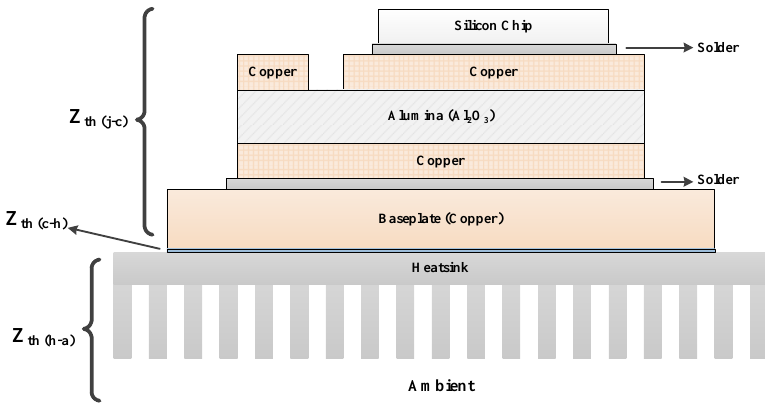
Figure 7. Cross−sectional representation of IGBT power module. Figure 7. Cross − sectional representation of IGBT power